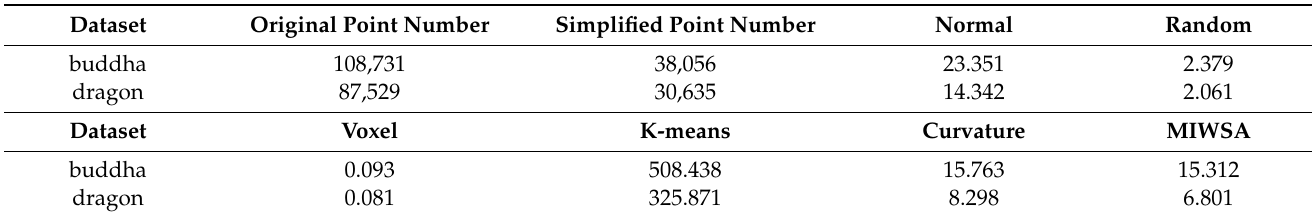
Table 3. Point numbers and running time for datasets buddha and dragon (unit: